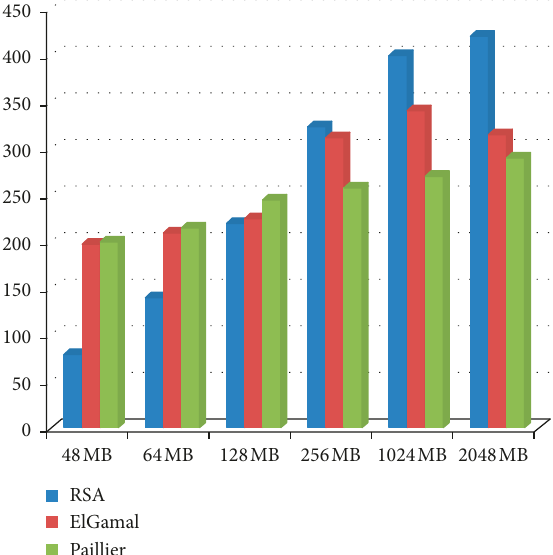
Figure 6: Time consumed to generate a key of different sizes by CKMS used by 3 different algorithms.